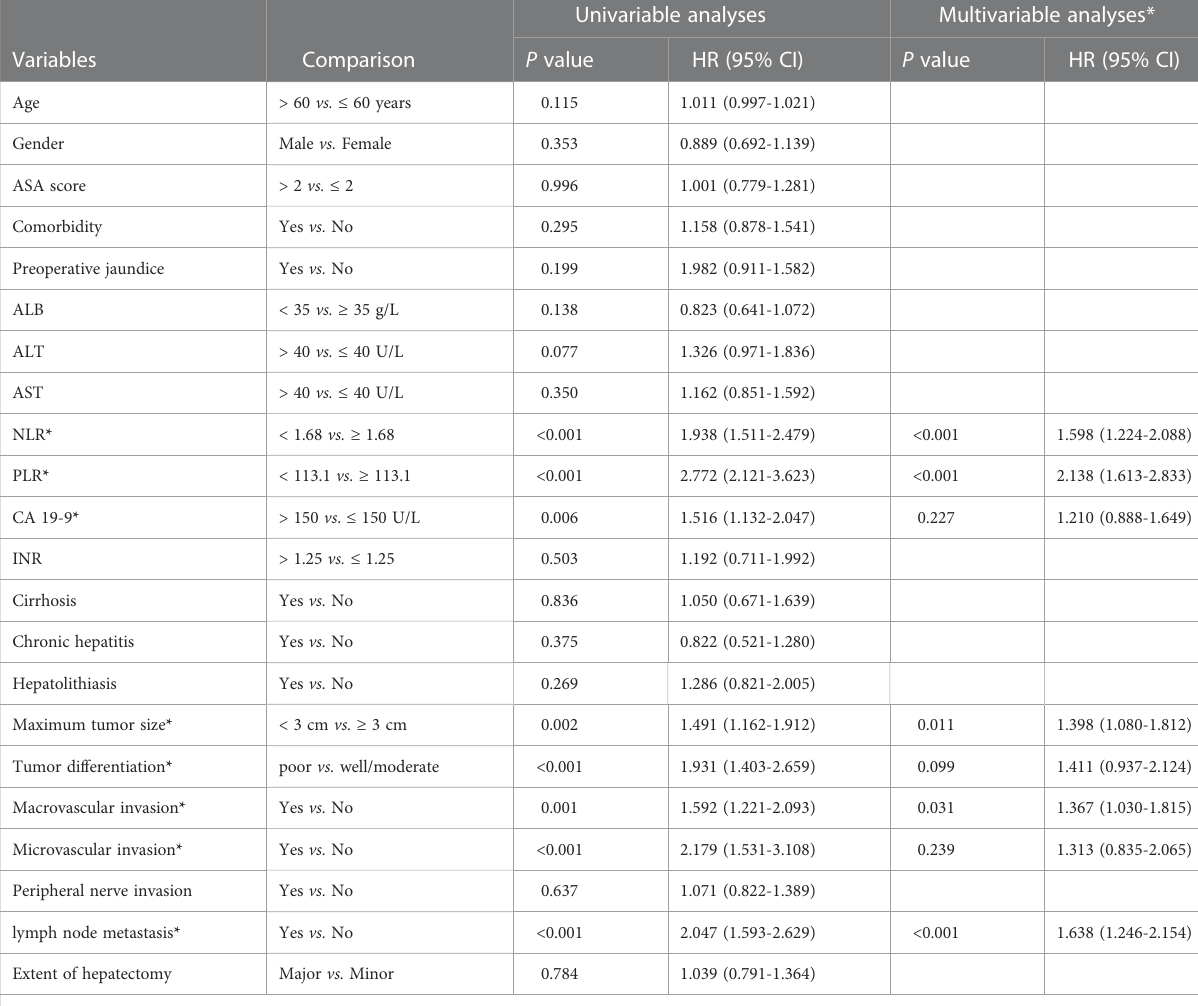
TABLE 4 Univariable and multivariable Cox regression analyses for RFS of pCCA